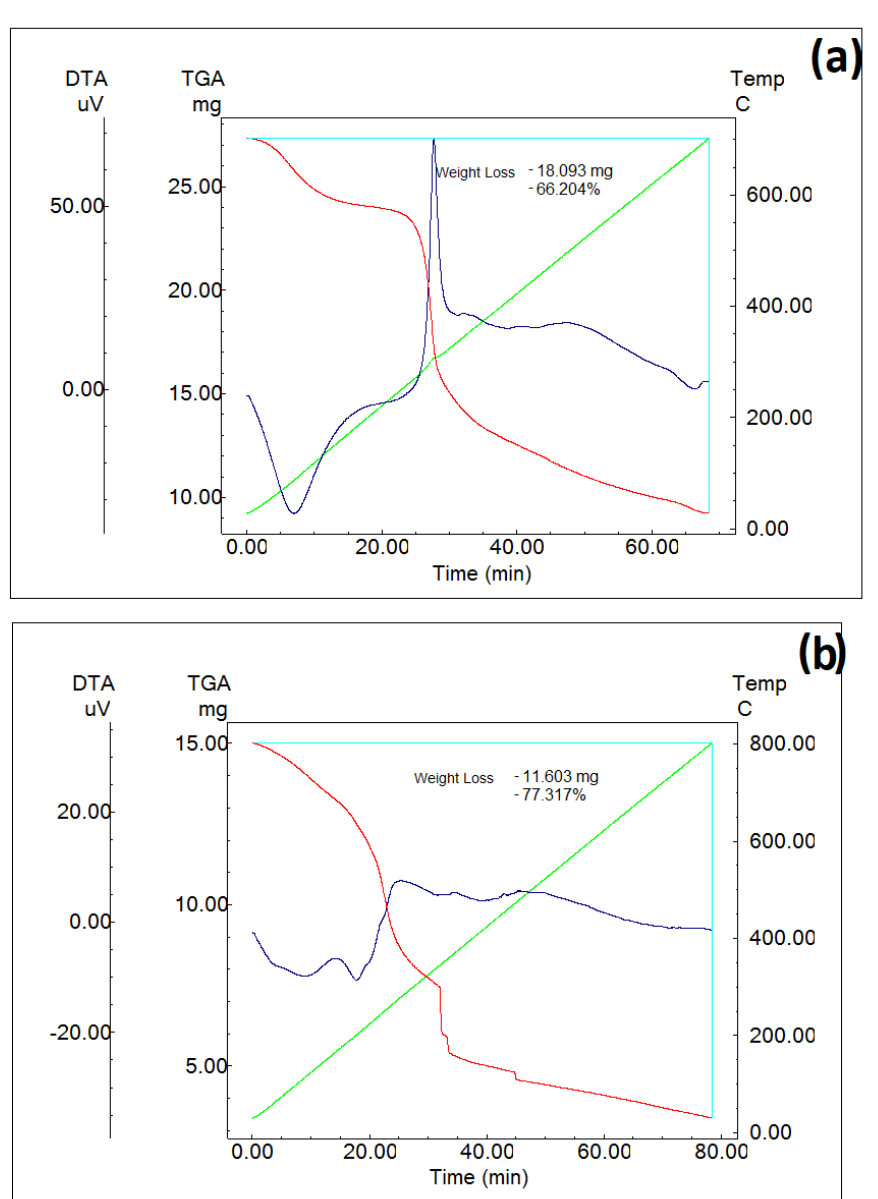
Figure 4. TGA and DTA curves of ( a ) parent chitosan and ( b ) Fe – CTB.